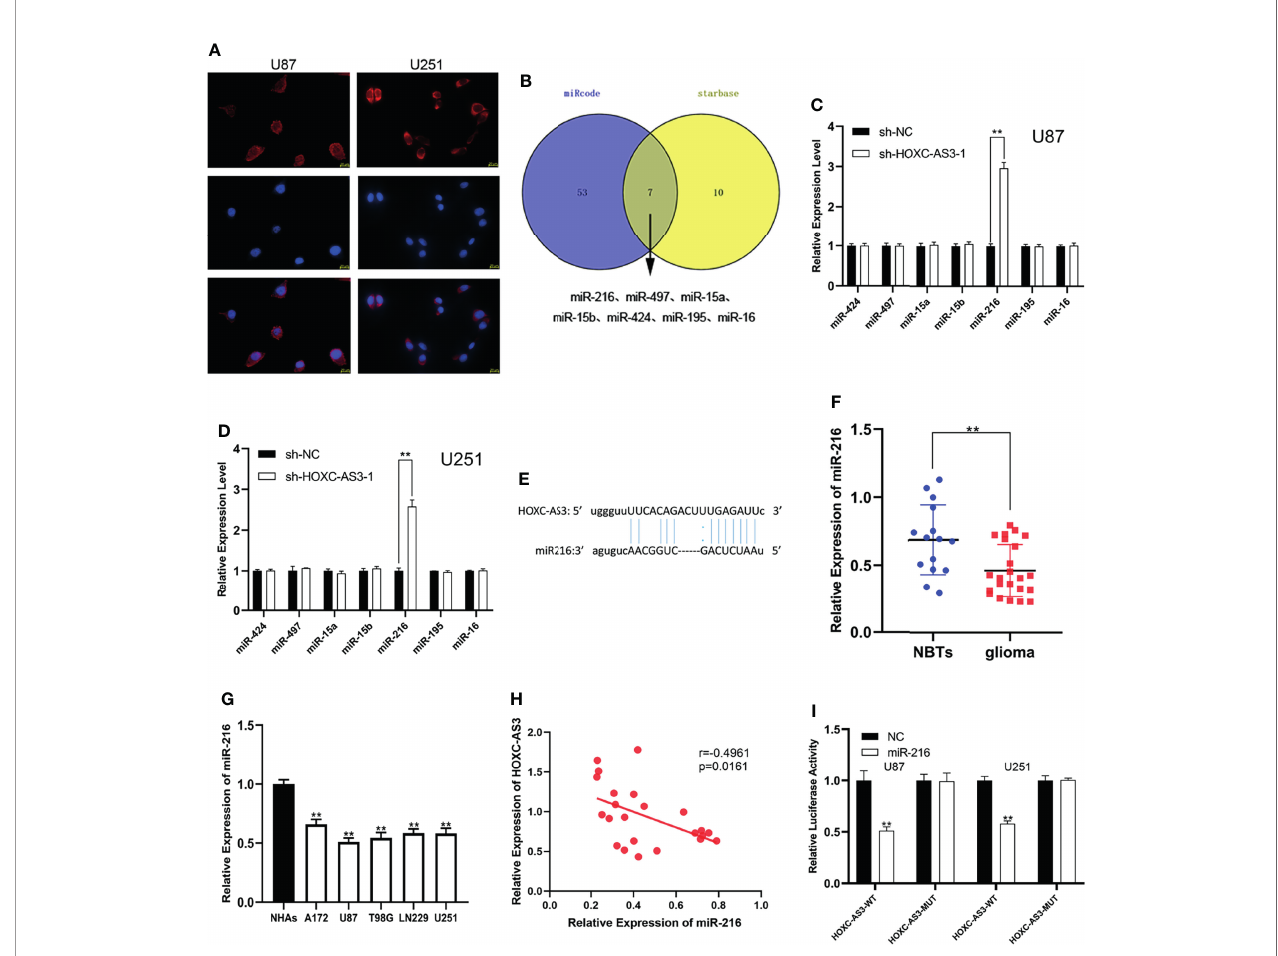
FIGURE 2 | HOXC-AS3 acts as a sponge for miR-216. (A) The distribution of HOXC-AS3 in U87 and U251 cells was evaluated by FISH assays. (B) Targets of HOXC-AS3 were predicted by online databases. (C, D) The expression of seven miRNAs was detected in glioma cells transfected with sh-HOXC-AS3-1 or shNC. (E) Binding sites of miR-216 on HOXC-AS3. (F) Expression of miR-216 in normal brain tissues and glioma tissues. (G) Expression of miR-216 in glioma cell lines. (H) Pearson correlation analysis showed that HOXC-AS3 was inversely correlated with miR-216 in glioma tissues. (I) The association between miR-216 and HOXC- AS3 was veri fi ed by luciferase reporter assay. Pearson ’ s correlation analysis for (H) ; t-test for (C, D, I) ; Mann-Whitney test for (F) ; one-way ANOVA and post hoc test for (G) . **P <